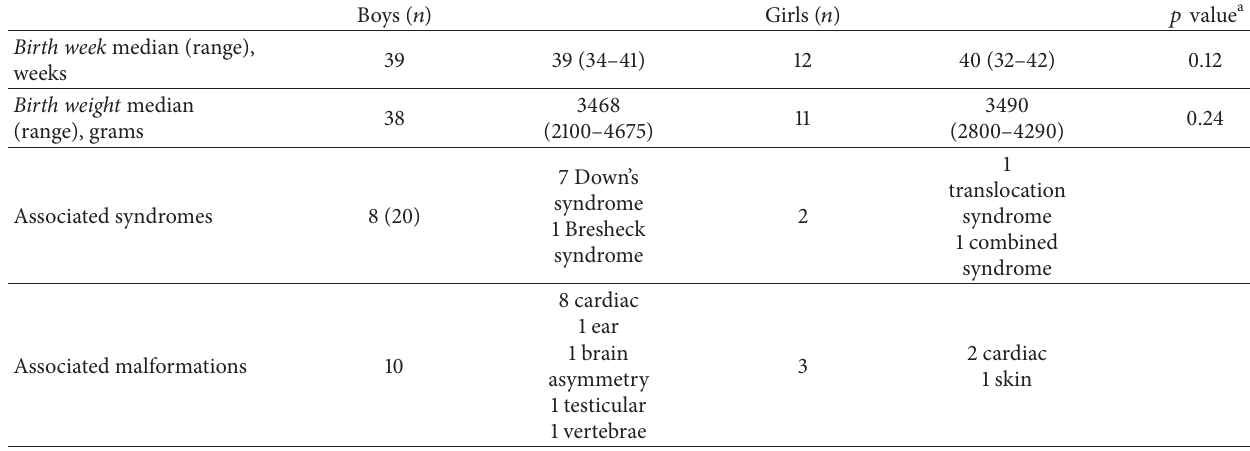
Table 1: Demographics of the included patients with HD who later underwent TERPT (%).